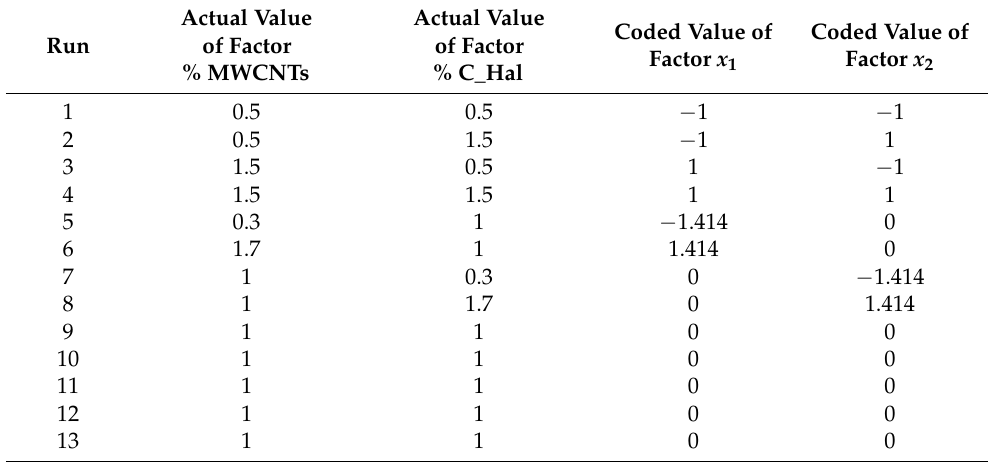
Table 1. Sample space—the set of the experiments to be performed by a two-factorial central composite